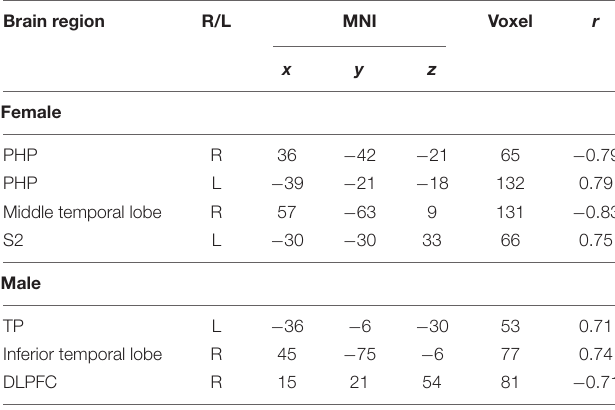
Abbreviations: MNI, Montreal Neurological Institute; DLPFC, dorsolateral prefrontal cortex; PHP, parahippocampal gyrus; S2, secondary somatosensory area; TP, temporal